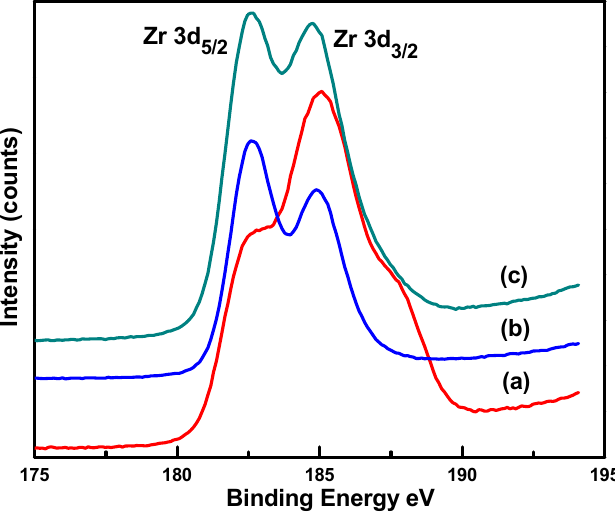
Figure 3 . XPS Zr 3d spectra of ( a ) CuZrIm0.5 ( b ) CuZrIm1 ( c ) CuZrIm1.5 . Figure 3. XPS Zr 3d spectra of ( a ) CuZrIm0.5 ( b ) CuZrIm1 ( c ) CuZrIm1.5.